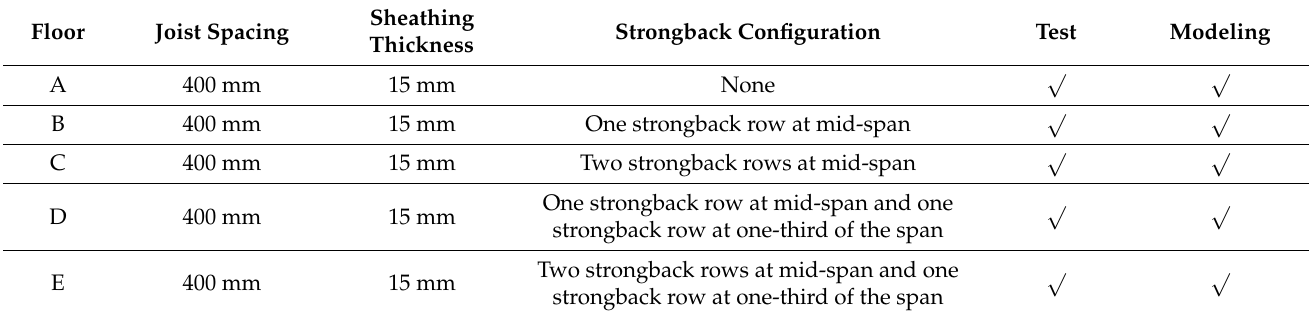
Table 1. Tested and modeled floors with different configurations.